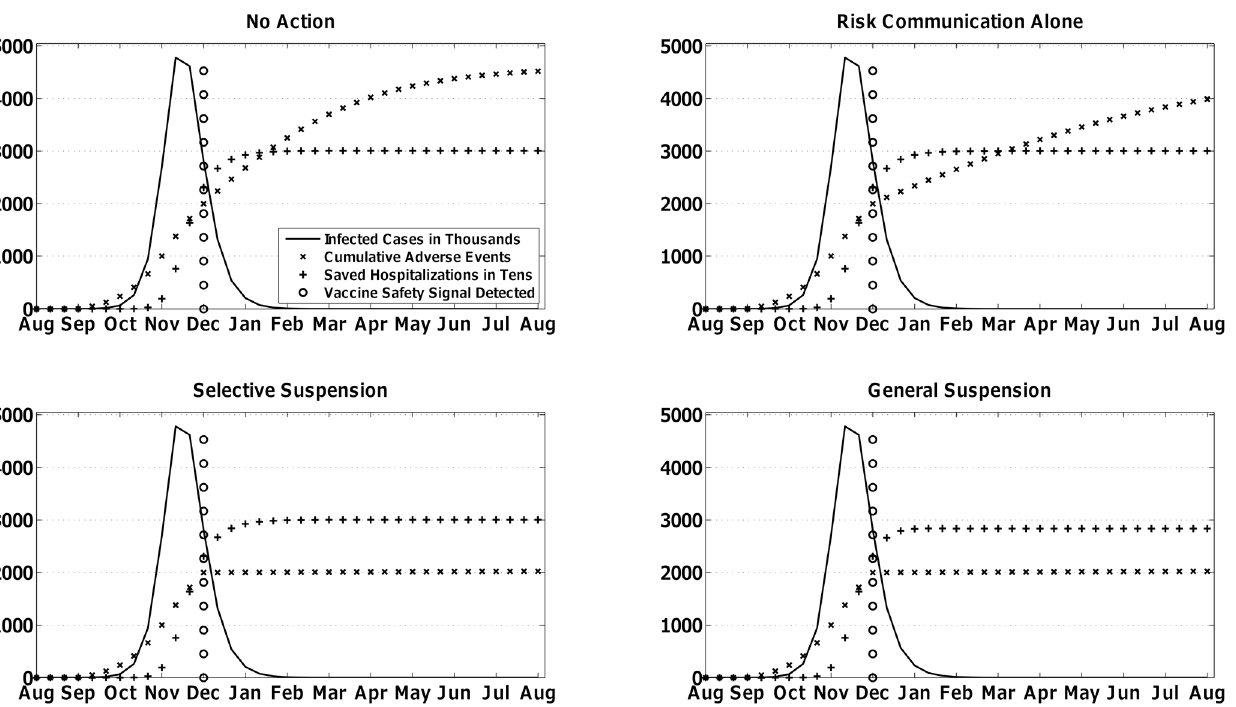
Fig. 3. One simulation run of the severe scenario with a febrile seizures safety signal received three months after the start of the vaccination campaign, i.e., December, which is four months after the start of the influenza pandemic scenario. The outcomes that occur with each of the four simulated regulatory responses are shown in each panel. The Multi-Criteria Decision Analysis model selected Risk Communication Alone as the preferred regulatory